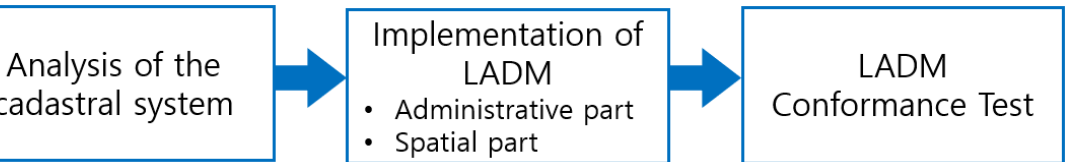
Figure 2. Research methodology flow diagram.